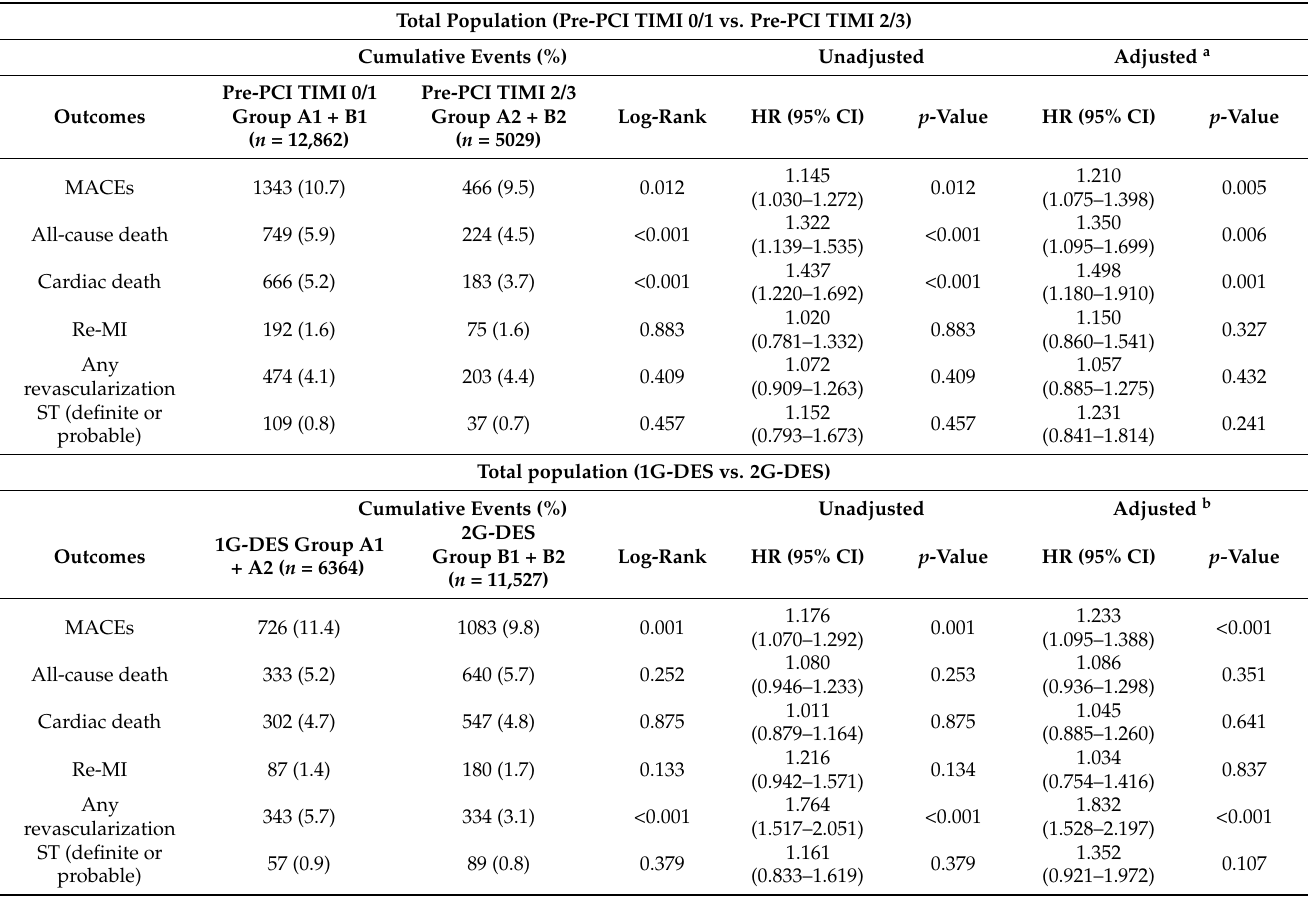
Table 3. Clinical outcomes by Kaplan-Meier analysis and Cox-proportional hazard ratio analysis at 2